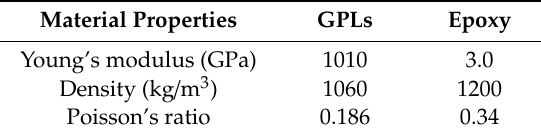
Table 3. Material properties of the GPLs and epoxy